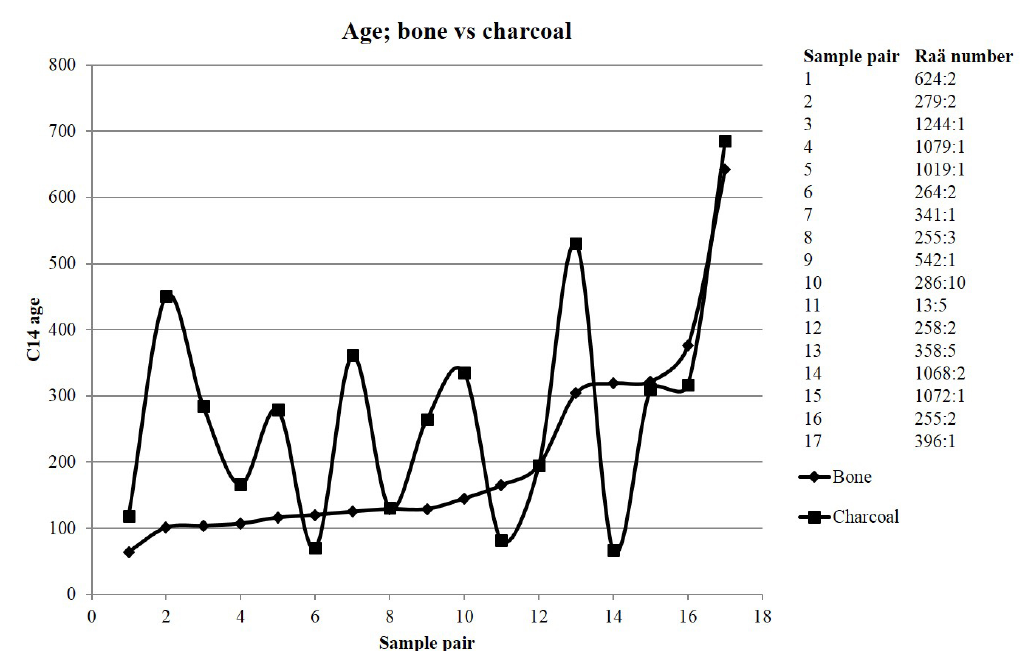
Figure 9. Pairs of bone and charcoal dates. The datings are arranged with a start in the latest bone dating with its counterpart made on